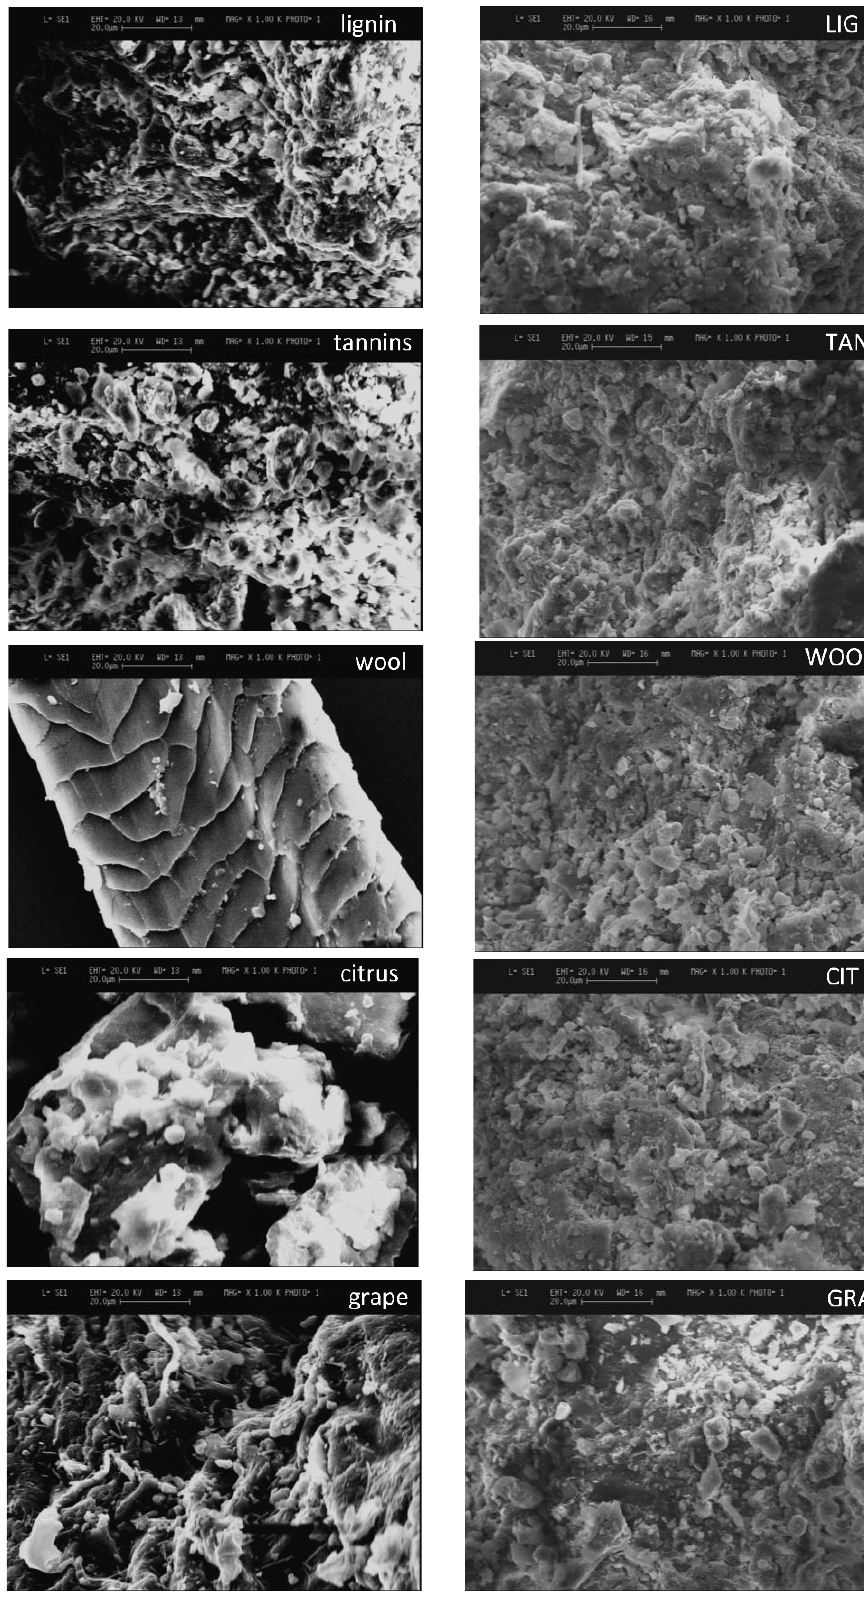
Figure 10. Comparison of the images of the pure additives and the specimens stabilized using the same additive, at the same magnification ×1000.